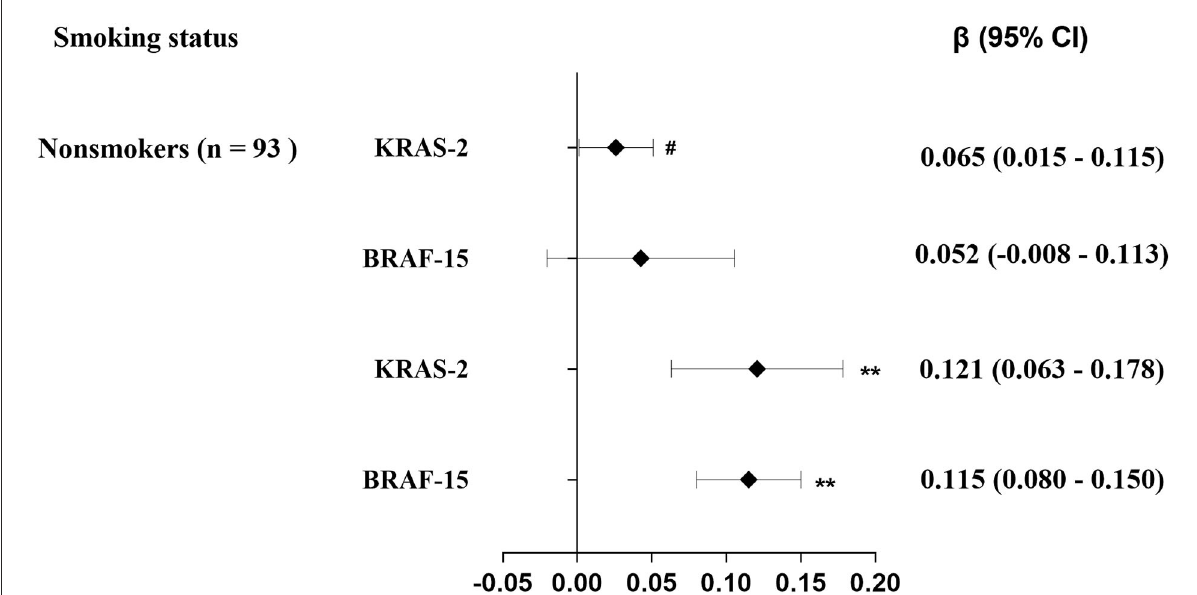
FIGURE2 Stratification analysis of the estimated difference in exon genetic damage index [ β (95% CI)] associated with a 1-SD increase in exposure levels of urinary1-OH-Pyr among 288 coke oven workers by smoking status. The lines in panels represent β (95% CI) based on multiple linear regression models adjusted for working years and workplace; # p = 0.045 > 0.025; ** p < 0.001.